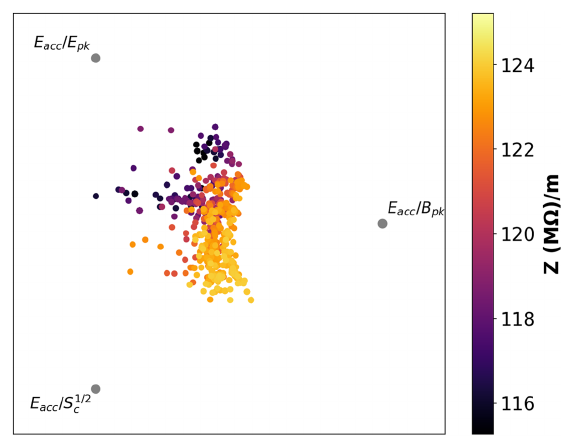
FIG. 13. 3dRadVis example showing three surface fields as objectives with color dimension showing Z